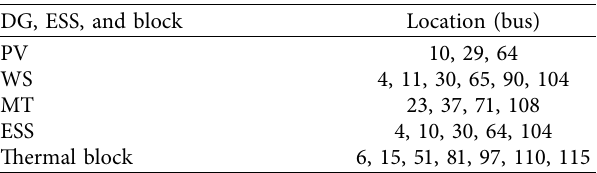
Table 2: Locations of DGs, ESSs, and thermal blocks in the 119-bus